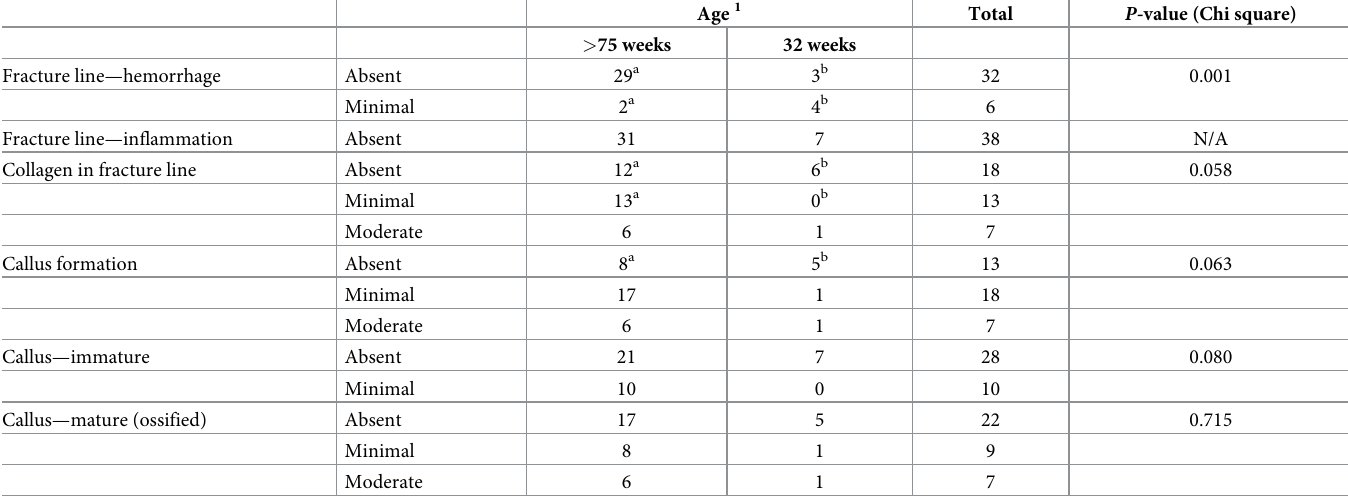
Table 4. Overview of inflammatory response and fracture repair in 38 birds with fracture lines in the caudal part of the keel bone observed by histological evaluation.